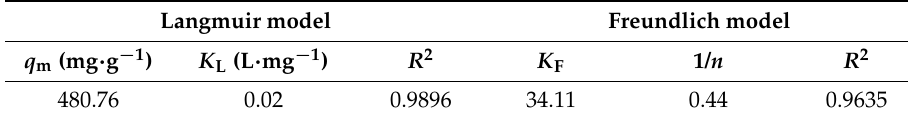
Table 3. Adsorption isotherm parameters of Langmuir and Freundlich models. Langmuir model